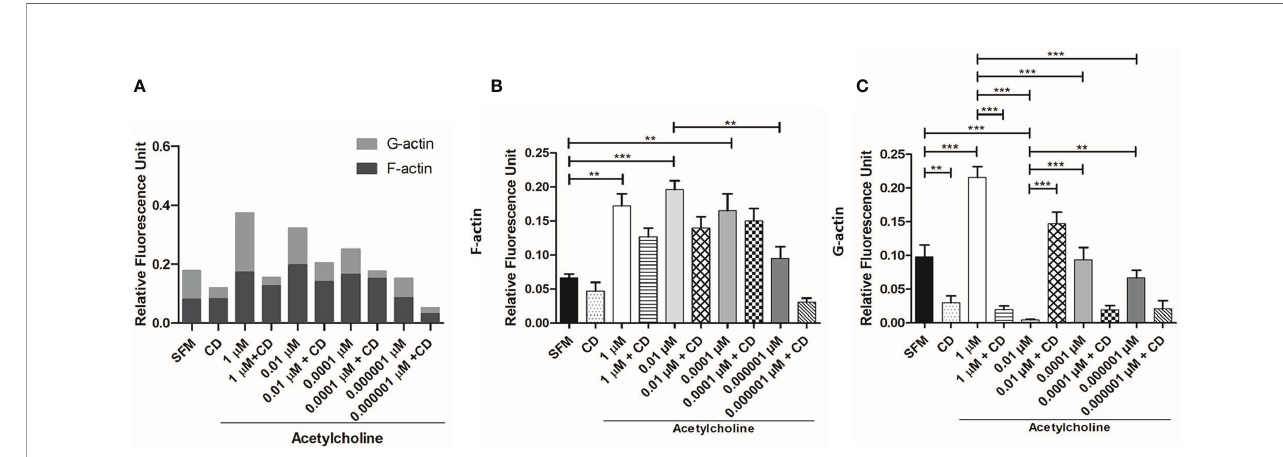
FIGURE 6 | Quantitative analysis of fl uorescence intensity of F- and G-actin. Analysis of fl uorescence intensity was done at the original magni fi cation by measuring the mean gray value with ImageJ software. (A) Combined determination of F- and G-actin in ACh-treated trophozoites. Determination of FMI for (B) F-actin and (C) G-actin. Data correspond to the mean ± SEM of three independent experiments (n = 3). The statistical analysis was performed with the Kruskal Wallis and Dunn posttest method, where the values of **p< 0.01 and ***p < 0.001 were considered signi fi